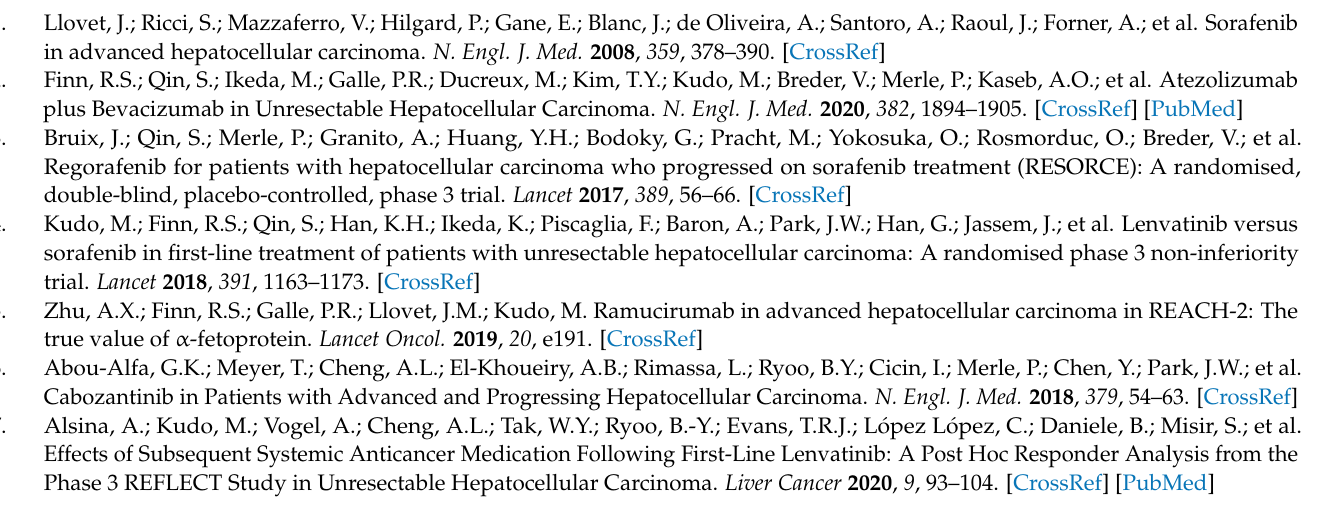
Table S2: Characteristics of 356 patients with hepatocellular carcinoma according to the skeletal muscle volume, Table S3: Characteristics of 320 patients with hepatocellular carcinoma according to the skeletal muscle volume, Table S4: Univariate and multivariate analyses for predictors of progression-free survival, Table S5: Univariate and multivariate analyses for prognostic factors of post-progression